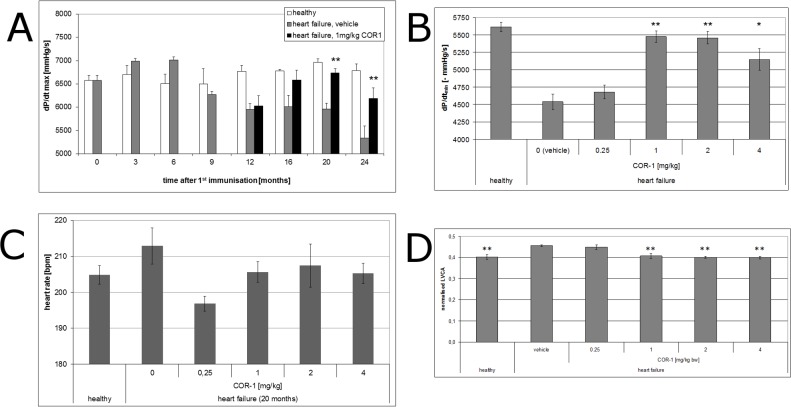
Contractility (dP/dtmax), relaxation (dP/dtmin), heart rates and left ventricular cavity areas (LVCA) of healthy rats and HF rats treated with either vehicle or COR-1.A: Time course of contractility (dP/dtmax) The myocardial contractility of healthy rats (white diamonds, n = 3 to 6) and of ß1EC2HF rats receiving vehicle (grey squares, n = 3 to 5), respectively, was measured at intervals of three and four months by cardiac catheterization. From the 12th month after the first immunization on, 1 mg/kg COR-1 treated HF rats were included in the analysis (black triangles, n = 4 to 10). Mean dP/dtmax with SEM are shown for all rats analysed at a same time point (n = number of respective rats). ** indicates strong statistical significance (p<0.005) compared to the HF vehicle group. Analysis of variance (ANOVA) revealed no differences at baseline, but significant worsening of dp/dt max in immunized HF-rats compared to healthy control ratsat the 12th, 20th and 24th month after the first immunisation. HF-rats treated with 1 mg/kg COR-1 differed significantly from the HF vehicle group, but did not significantly differ from healthy control rats at 20 and 24 months. B: Relaxation (dP/dtmin) of healthy rats and HF rats treated with either vehicle or COR-1 Means ± SEM of the myocardial relaxation of HF rats are shown after ten treatments (20 months after the first immunization), including the groups treated with vehicle (n = 5), or 0.25 mg/kg COR-1 (n = 4), 1 mg/kg COR-1 (n = 10), 2 mg/kg COR-1 (n = 5), or 4 mg/kg BW COR-1 (n = 9), respectively. For comparison, mean heart rates are also shown for healthy control rats (n = 6).* indicates statistical significance (p<0.05), and ** indicates strong statistical significance (p<0.005), compared to the HF vehicle group. C: Effect of COR-1 on the heart rate of rats with HF induced by immunisation with GST-ß1EC2 fusion proteins The effect of COR-1 on the heart rate of ß1EC2HF ratswas evaluated after ten monthly treatments (20 months after the first immunization). Means ± SEM of heart rates of HF rats are shown, treated with vehicle (n = 5), or 0.25 mg/kg COR-1 (n = 4), 1 mg/kg COR-1 (n = 10), 2 mg/kg COR-1 (n = 5), or 4 mg/kg BW COR-1 (n = 9), respectively. For comparison, mean heart rates are also shown for healthy control rats (n = 6). No significant differences were observed.The mean heart rate of the rats did not differ significantly between the groups (p = 0,173 by ANOVA). D: Left ventricular cavity areas (LVCA) of healthy rats and HF rats treated with either vehicle or COR-1 Means ± SEM of the normalized LVCA (ratio of LVCA divided by the respective left ventricular area) of HF rats after ten treatments (20 months after the first immunization), including the groups treated with vehicle (n = 5), or 0.25 mg/kg COR-1 (n = 4), 1 mg/kg COR-1 (n = 10), 2 mg/kg COR-1 (n = 5), or 4 mg/kg BW COR-1 (n = 9), respectively. For comparison, mean normalized LVCAs are also shown for healthy control rats (n = 6).** indicates strong statistical significance (p<0.005 by ANOVA), compared to the HF vehicle group.